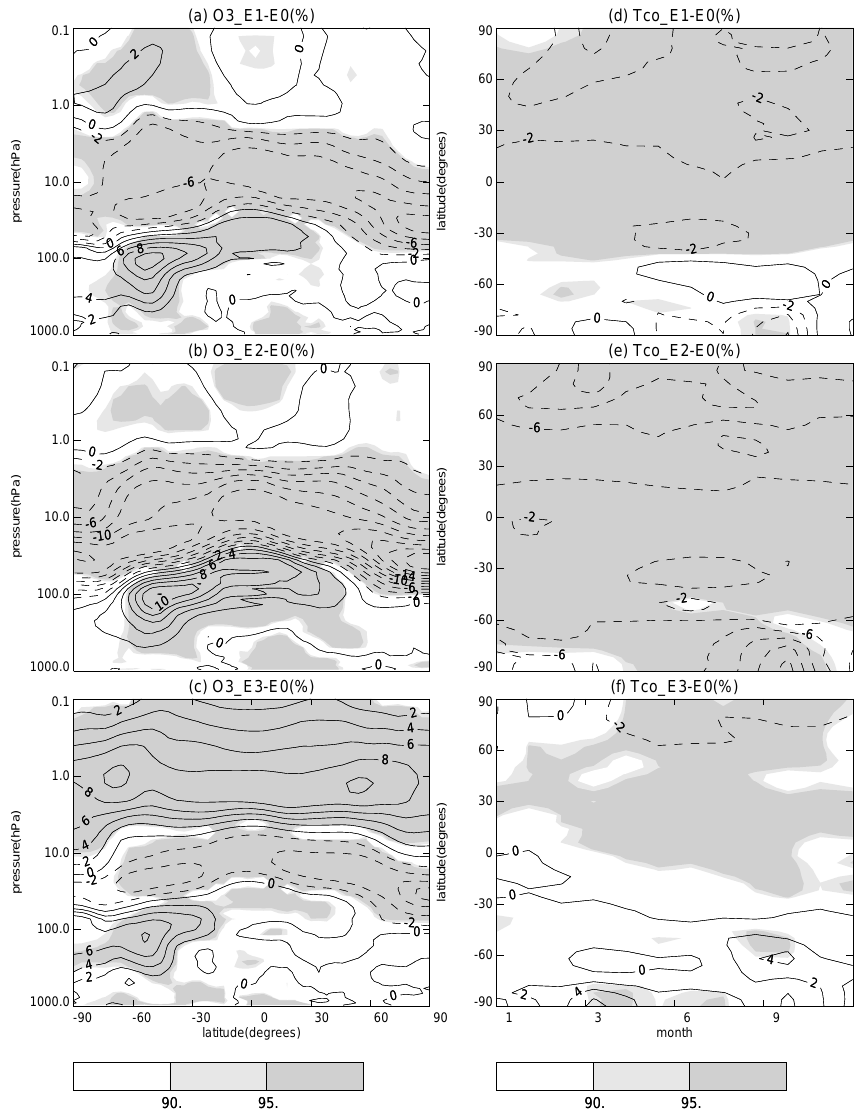
Figure 2. Latitude–pressure cross sections of differences (%) in zonal mean ozone mixing ratios (2041–2050) between WACCM experiments (a) E1 and E0, (b) E2 and E0, and (c) E3 and E0. Time–latitude cross sections of differences (%) in zonal mean total column ozone climatology (2041–2050) between experiments (d) E1 and E0, and (e) E2 and E0, (f) E3 and E0. The percentage is the ratio of the ozone and TCO changes (E1, E2 and E3 minus E0) referenced to the run E0. The contour interval is 2% for percentage ozone changes. The grey colours represent significance levels for the mean state differences between different experiments by Student’s t